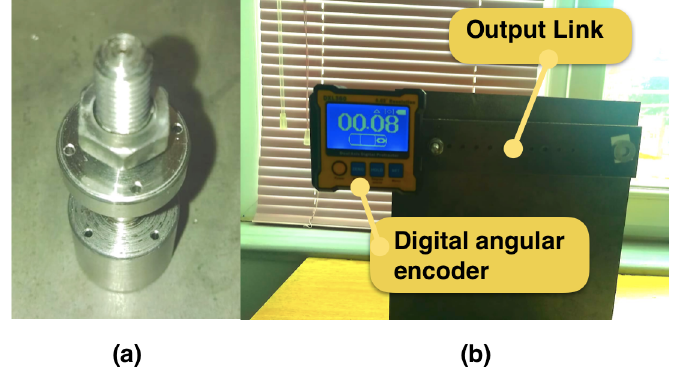
Figure 7. Prototype of the proposed actuator: ( a ) stiffness adjustment module and ( b ) experimental